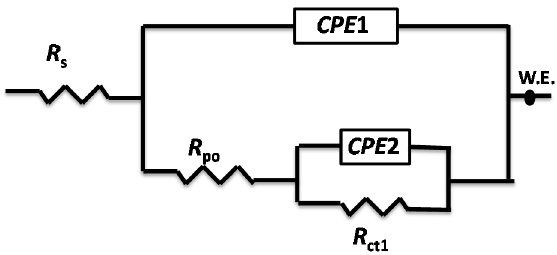
Figure 9. Equivalent electrical circuit used to fit the EIS spectra of the uncoated Al alloy and the as-prepared SHCs in saline water. Table 5. The electrochemical parameters from Nyquist and Bode plots for the uncoated and coated aluminum substrates with pure electrospun PS (PS1 & PS3), and nanocomposite SHCs of polystyrene and aluminum oxide (PA1 & PA3), in 3.5 wt % NaCl solution.